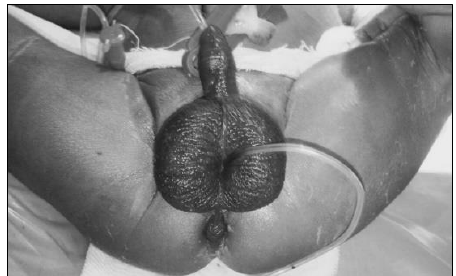
Figure 1: Anorectal atresia with fistula in midline in mid- scrotum.